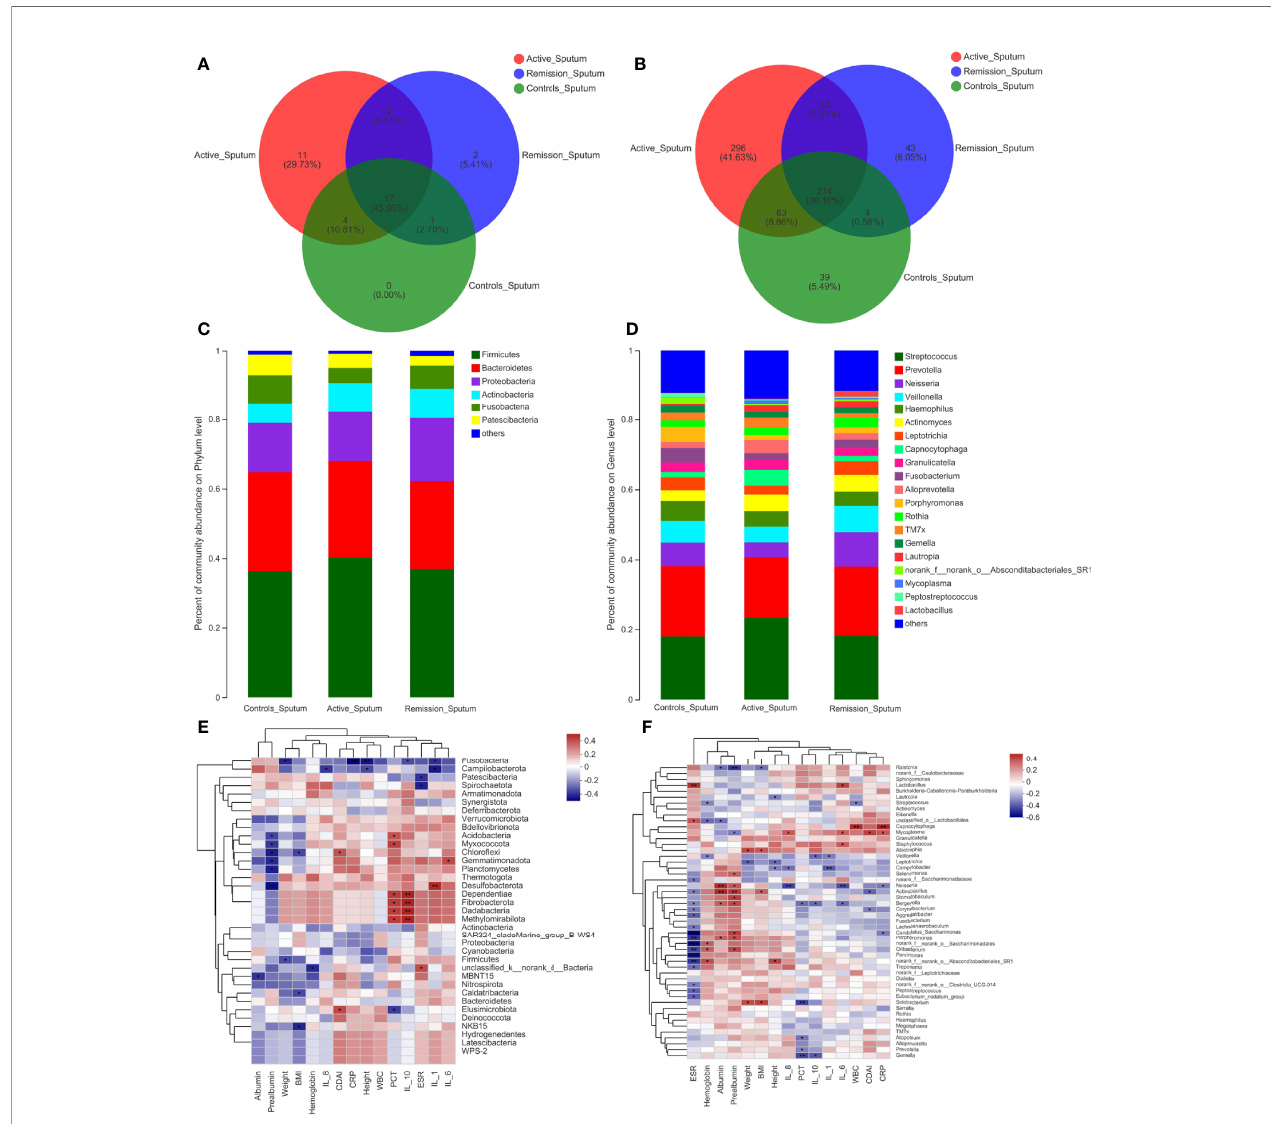
FIGURE 5 | Structure analysis of the sputum microbiota in patients with CD. (A, B) Venn diagram indicating the overlap of OTUs in the categories on the phylum and genus levels, respectively. (C, D) Barplot of the relative abundances of different taxa on the phylum and genus levels, respectively. (E, F) Heatmap revealing the association between sputum microbiota and clinical factors on the phylum and genus levels, respectively. *, **, and *** correspond to p-values <0.05, 0.01, and 0.001,